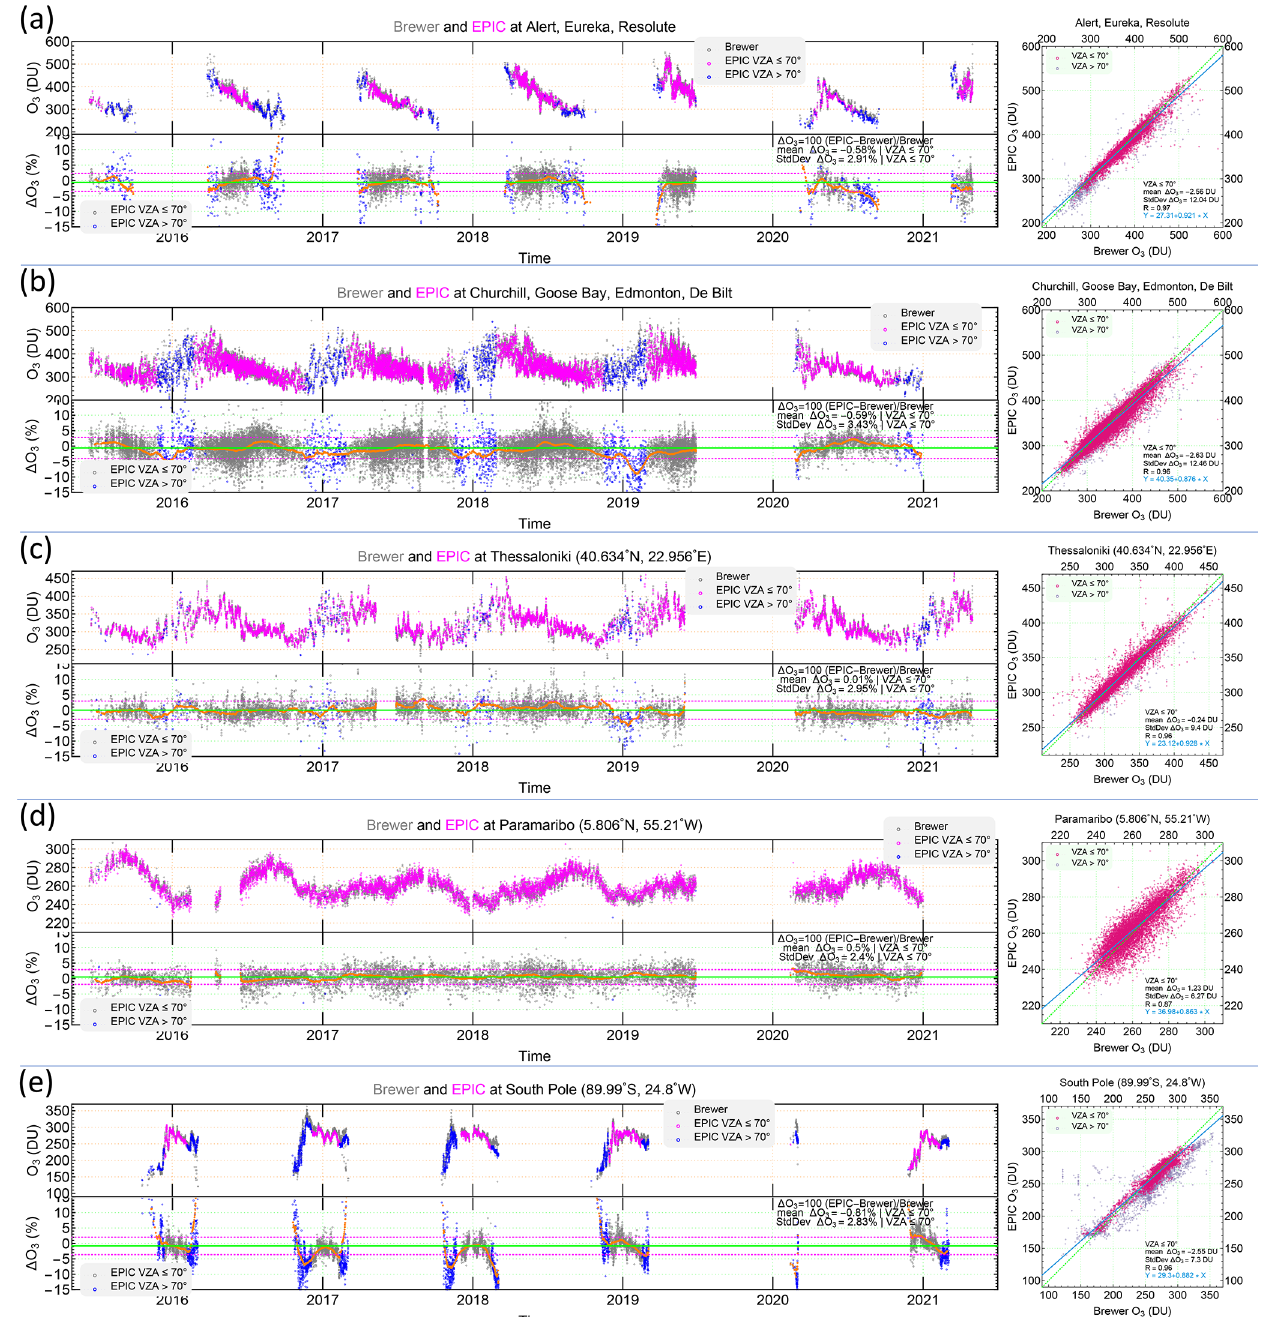
Figure 23. Intercomparison of total O 3 from EPIC and the ground-based Brewer spectrophotometers from July 2015 to April 2021 at 10 selected ground stations with high-cadence measurements: Alert (82.50 ◦ N), Eureka (79.99 ◦ N), Resolute (74.72 ◦ N), Churchill (58.75 ◦ N), Edmonton (53.55 ◦ N), Goose Bay (53.31 ◦ N), De Bilt (52.10 ◦ N), Thessaloniki (40.63 ◦ N), Paramaribo (5.806 ◦ N), and the South Pole ( − 89 . 99 ◦ N). EPIC and Brewer coincident pairs are used in the plots, and data with VZA ≤ 70 ◦ N only are included in the difference